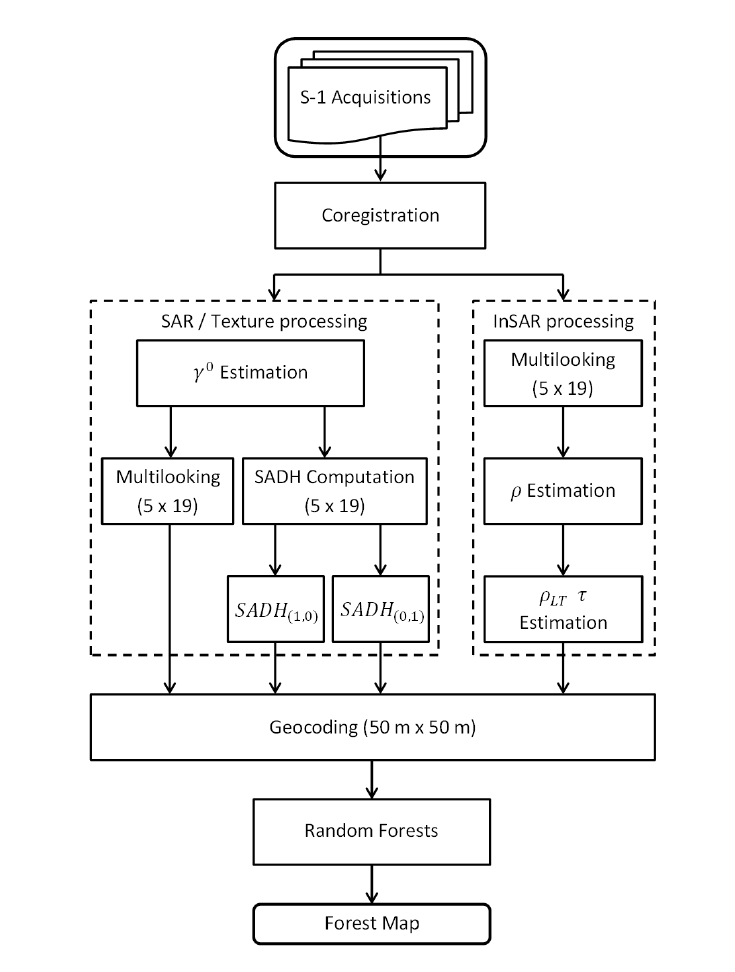
Figure 1. Developed processing chain for short-time-series, based on the architecture presented in [7], with the integration of Sum and Difference Histograms (SADH)